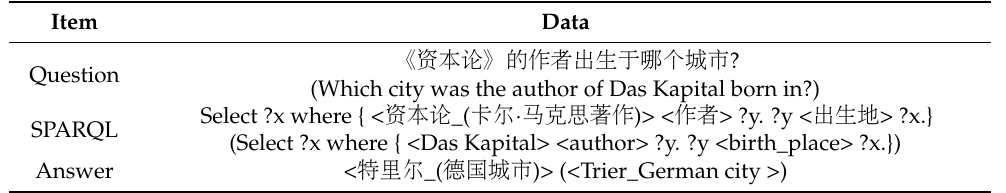
Table 3. The example of one piece of data in the CCKS 2019 CKBQA dataset.